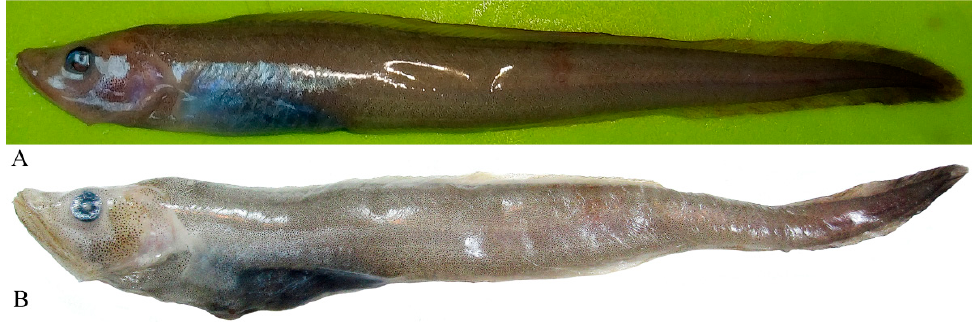
Figure 1. Lycodapus imperatorius sp. nov., holotype, IORAS 03641, 140 mm SL: ( A ) fresh caught, ( B ) after thawing.